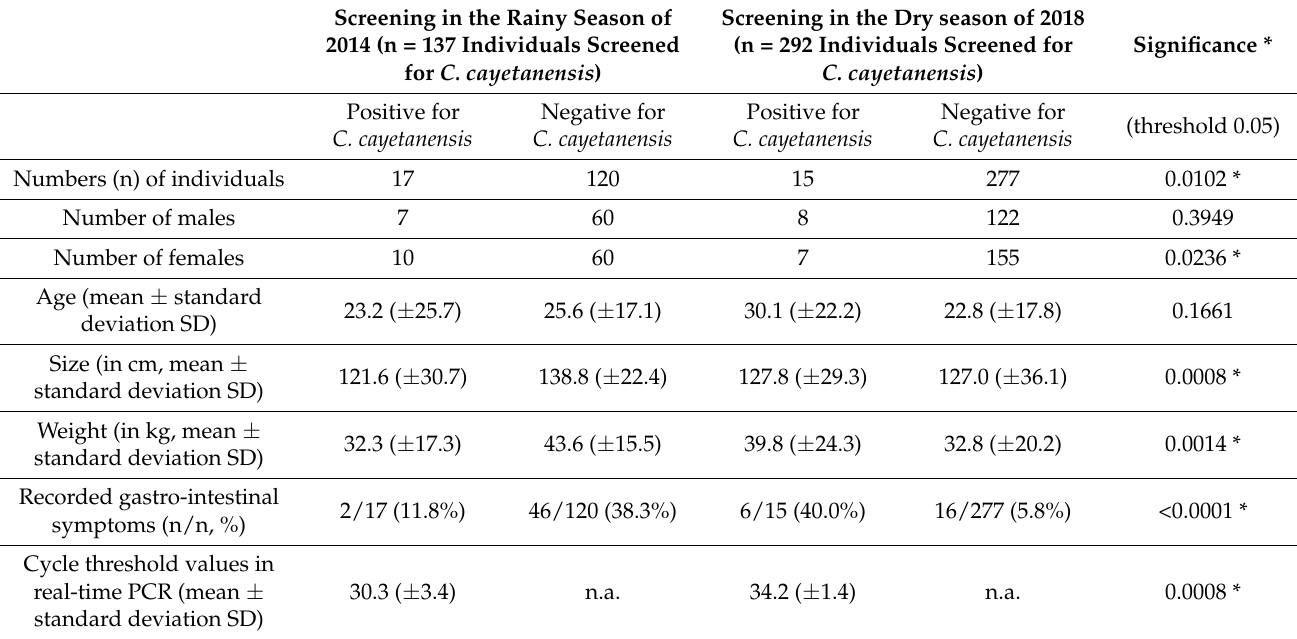
Table 1. Polymerase chain reaction (PCR)-based detection of Cyclospora cayetanensis in the course of the two screenings in 2014 and 2018 as well as associated patient